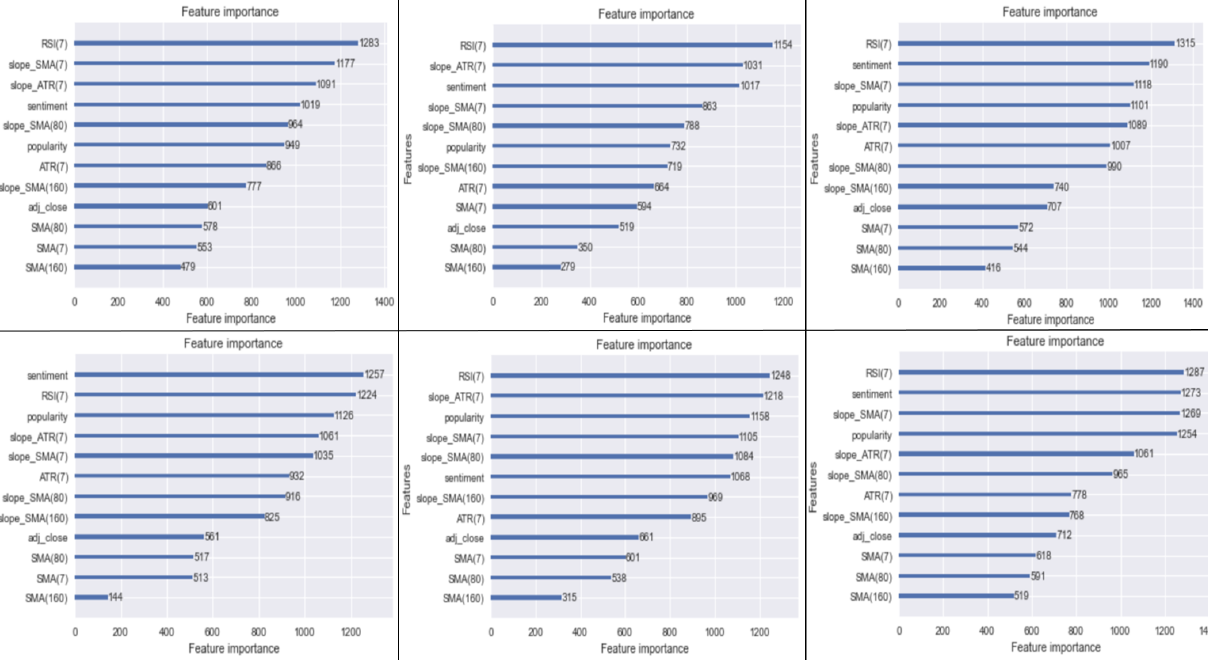
Figure 8. Feature importance plots of LightGBM for six stocks.